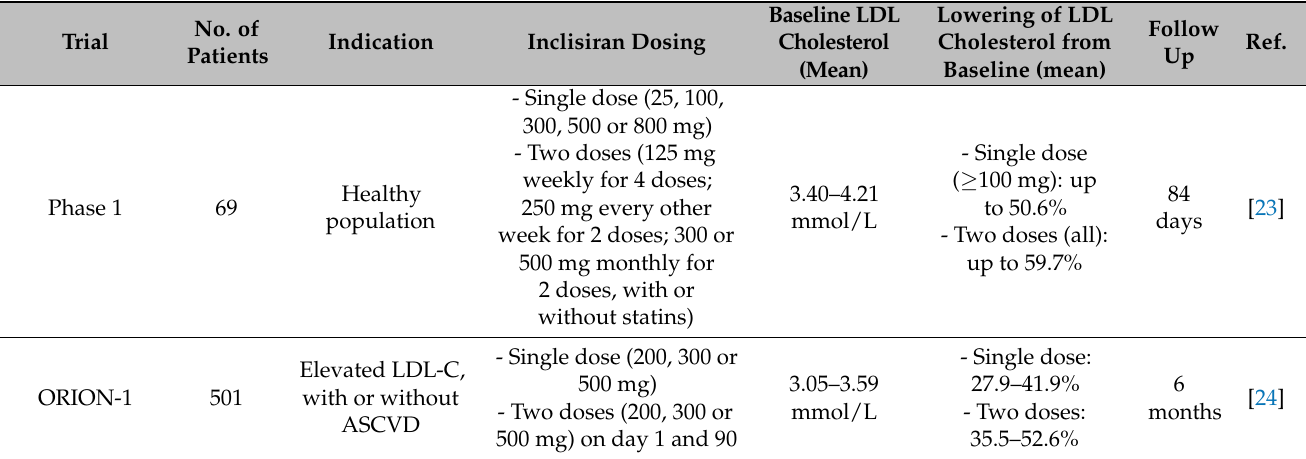
Table 1. Overview of the major clinical trials testing inclisiran as a cholesterol-lowering agent. No. Trial